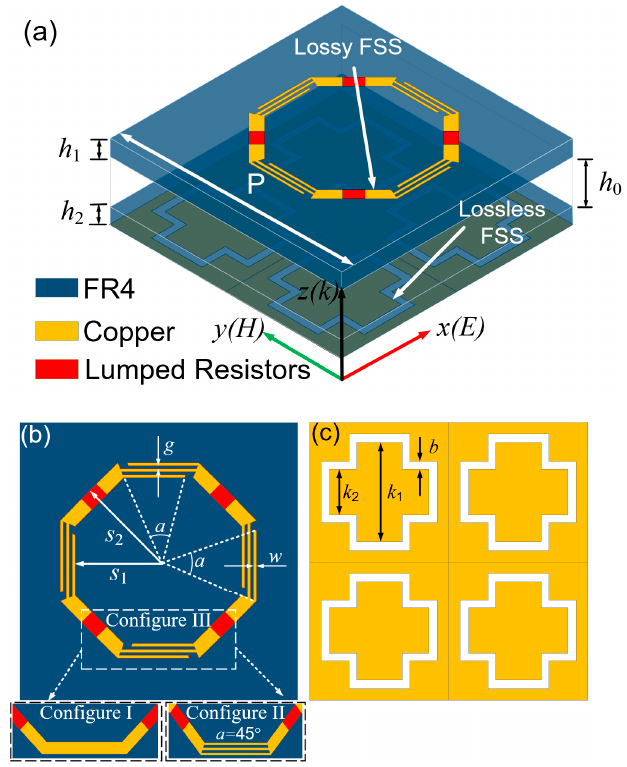
Figure 1. ( a ) Schematic of the FSR. ( b ) Lossy FSS. ( c ) Lossless FSS (geometrical dimensions: P = 14.6 mm, h 0 = 3.6 mm, h 1 = 1 mm, h 2 = 1 mm, s 1 = 3.98 mm, s 2 = 4.68 mm, w = 0.14 mm, g = 0.14 mm, α = 40°, k 1 = 5.2 mm, k 2 = 2.4 mm, b = 0.4 mm; all lumped resistors are 120 Ω ). g = 0.14 mm, α = 40 ◦ , k 1 = 5.2 mm, k 2 = 2.4 mm, b = 0.4 mm; all lumped resistors are 120 Ω